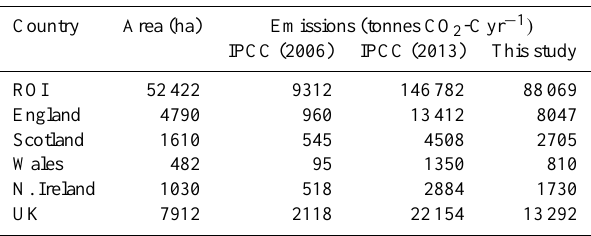
Table 4. Annual CO 2 -C emissions (in tonnes of CO 2 -Cyr − 1 ) from peatlands managed for extraction in the ROI and UK calculated us- ing the IPCC 2006 Good Practice Guidance (Tier 1 value: 0.2 and respectively), the IPCC 2013 Wetlands Supplement (Tier 1